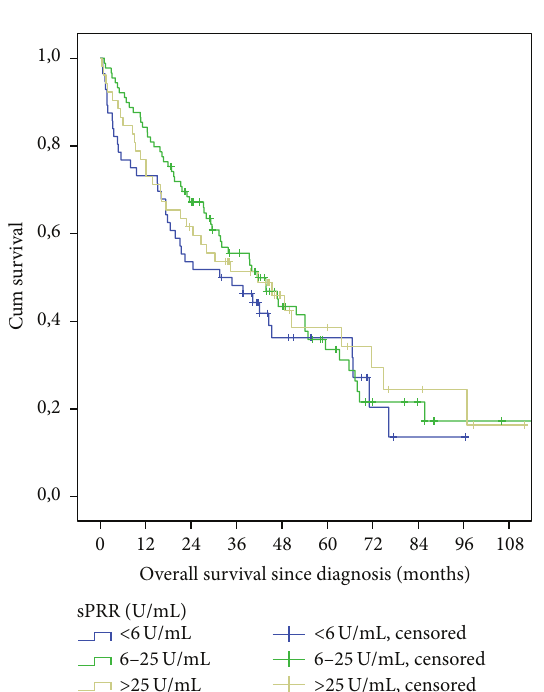
Figure 3: Overall survival curves for sPRR-level subgroups ( 𝑝 = 0.395